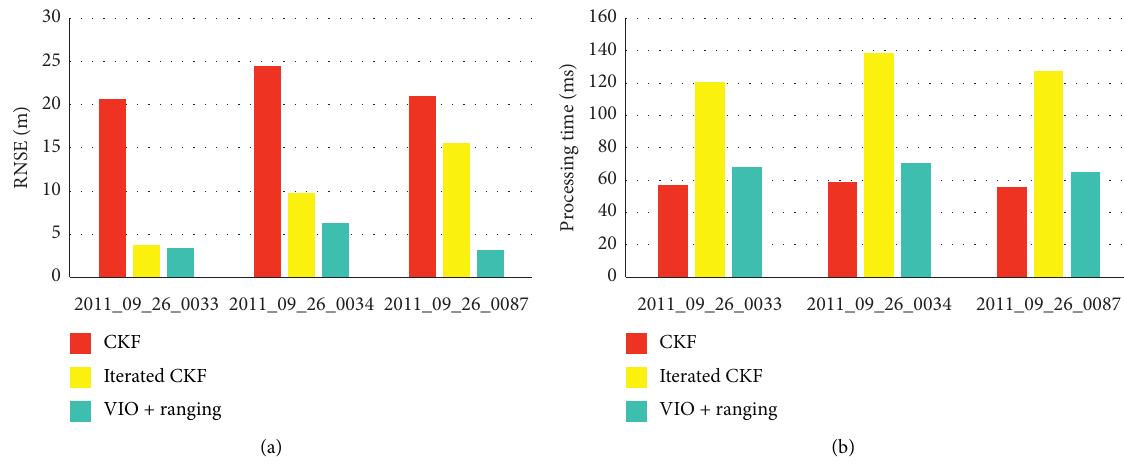
Figure 16: Average RMSE (a) and processing time (b) of position estimation between these solutions.